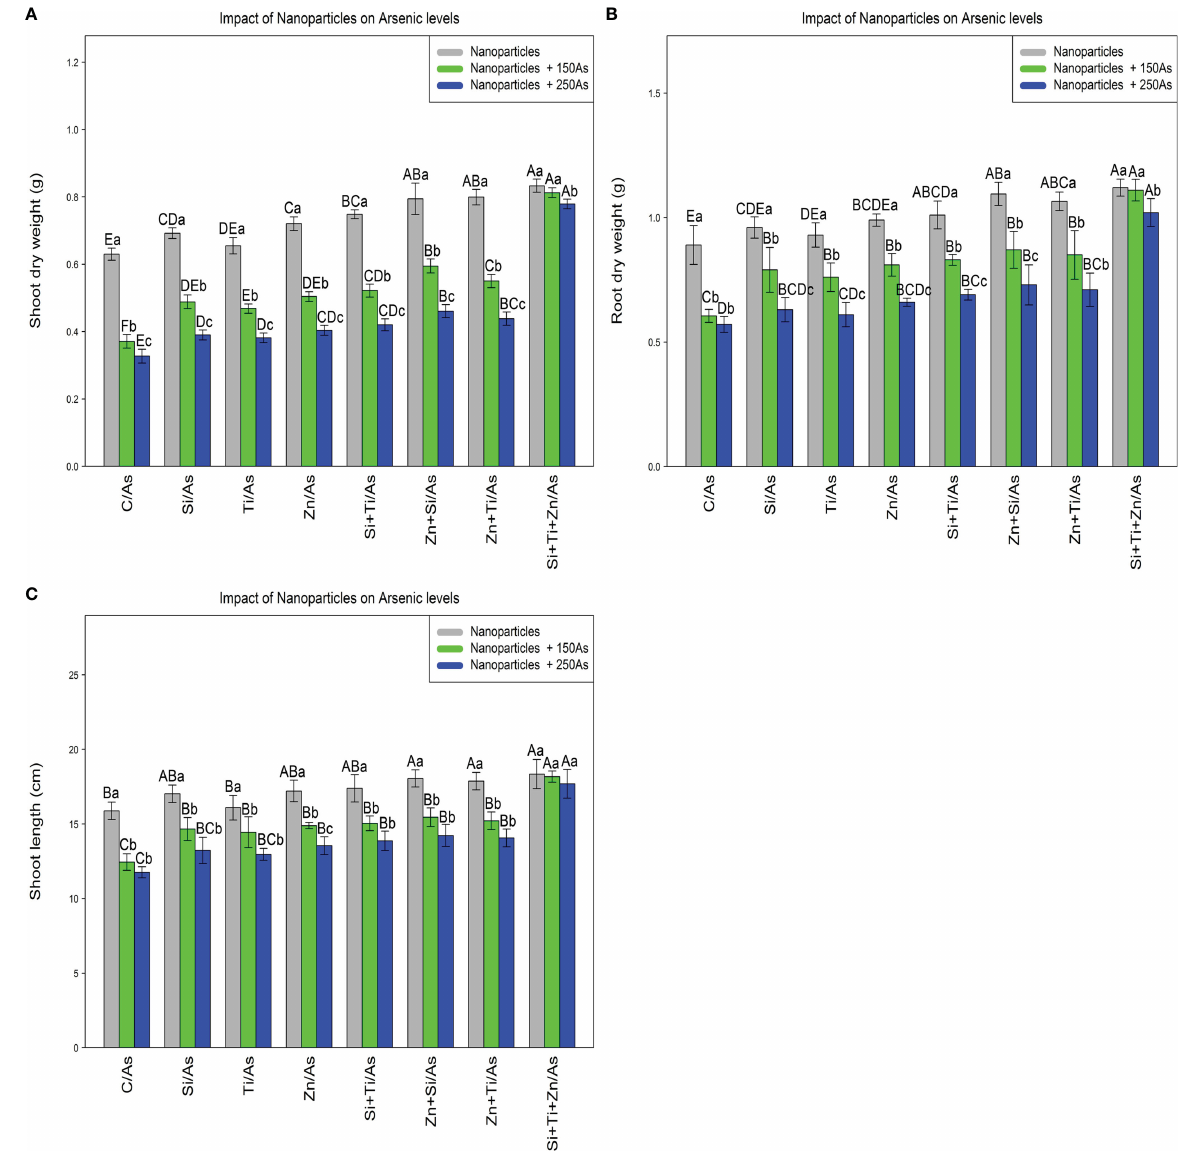
FIGURE 6 The impact of NPs alone and in combination on shoot dry weight (A) , root dry weight (B) , and shoot length (C) in one-year-old Pleioblastus pygmaeus exposed to 150 and 250 µM As (four replicates). In this fi gure, the letters a, b, c, etc. indicated signi fi cant differences following the application of NPs with 150 and 250 µM As based on Tukey ′ s test (p<